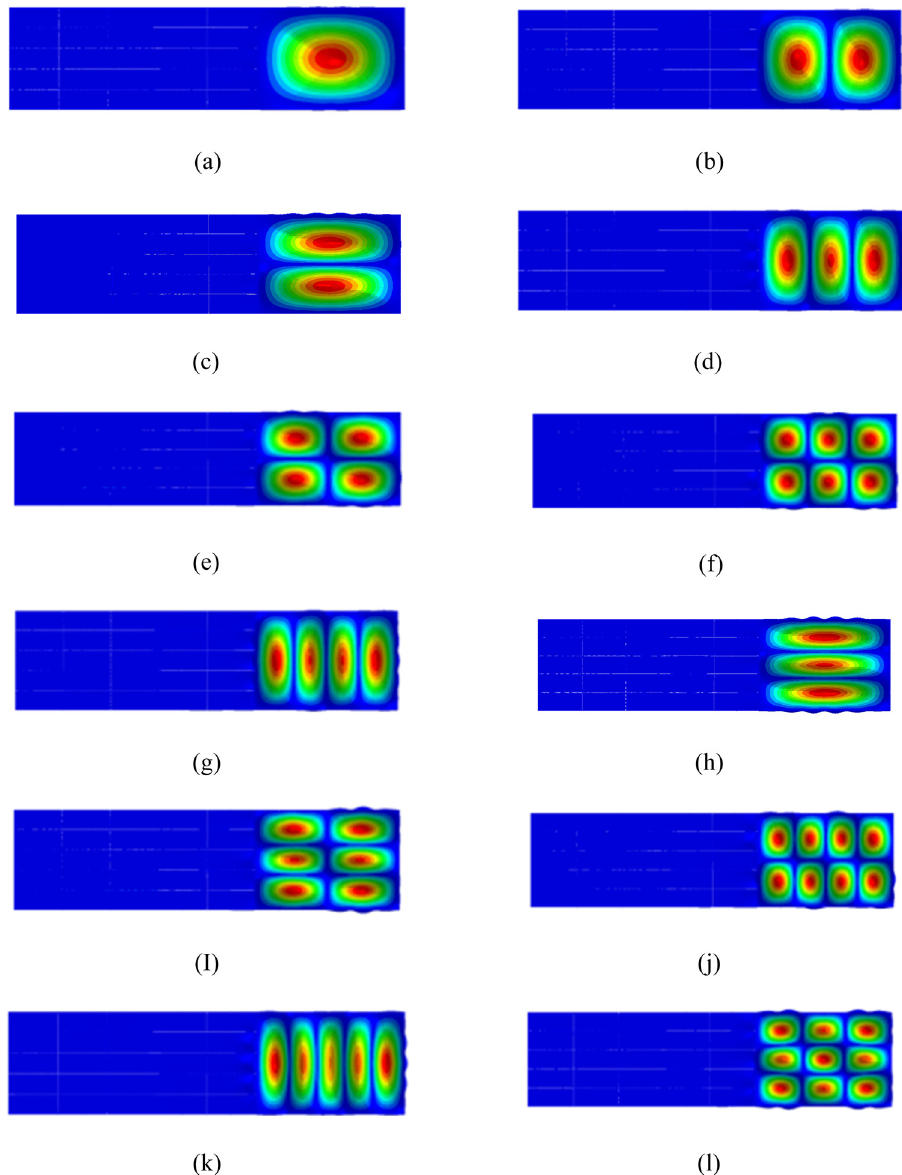
Figure 2: Modal results of multicompartment truss: ( a ) 5.2 Hz, ( b ) 8.3 Hz, ( c ) 12.5 Hz, ( d ) 13.6 Hz, ( e ) 15.4 Hz, ( f ) 20.4 Hz, ( g ) 20.9 Hz, ( h ) 23.7 Hz, ( i ) 26.5 Hz, ( j ) 27.5 Hz, ( k ) 30.2 Hz, and ( l ) 31.4